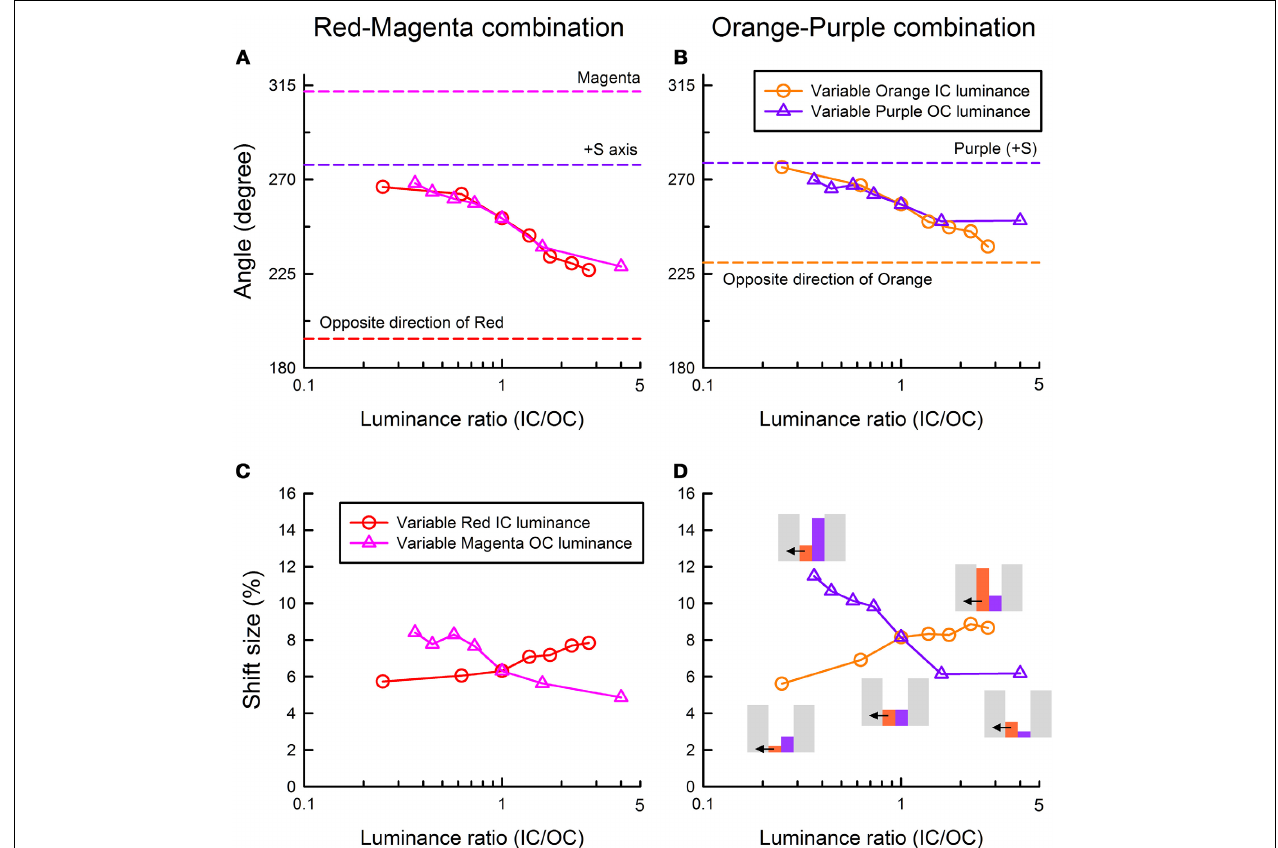
FIGURE 4 | Color direction and shift size of the cancelation settings as a function of the IC/OC luminance ratio. (A,C) The results for the red IC and magenta OC combination, and (B,D) the results for the orange IC and purple OC combination. Upper panels show the results of color direction analysis, whereas lower panels show the results of shift size analysis. Circle symbols show the results in the variable IC luminance condition, while triangle symbols show those in the variable OC luminance condition. In the figures of